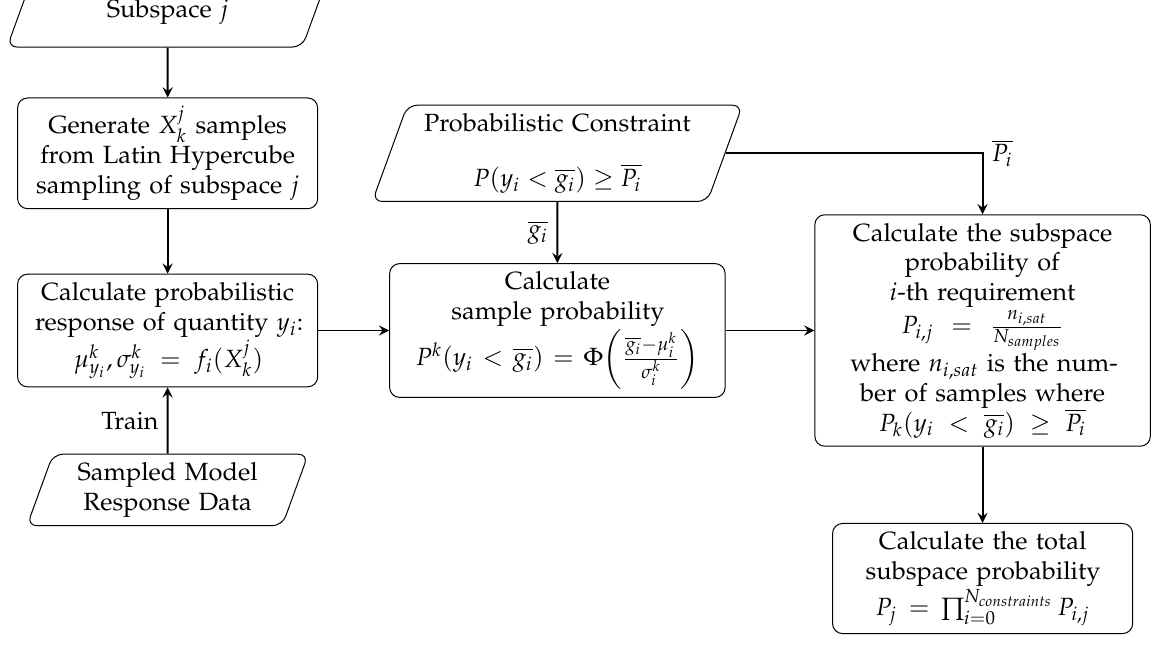
Figure 2. Flowchart of the exploration